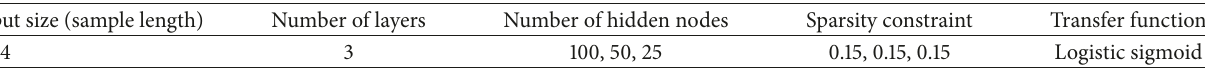
Table 4: Specifications for the training and design parameters of the stacked